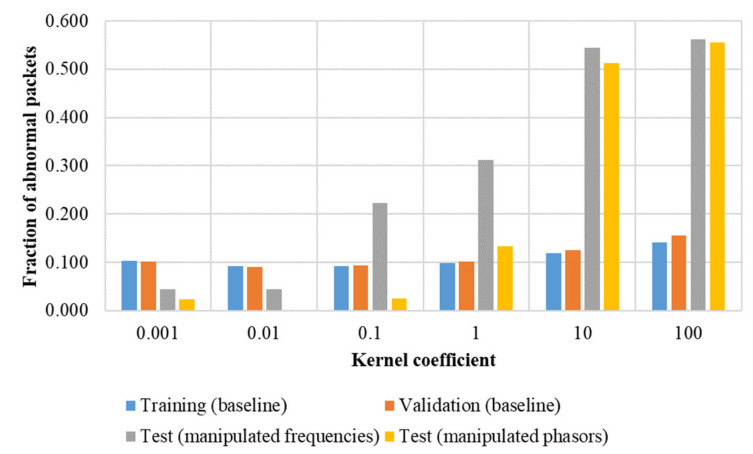
Figure 12. Number of detected normal and abnormal network packets by the OC-SVM for baseline and corrupted PMU traffic